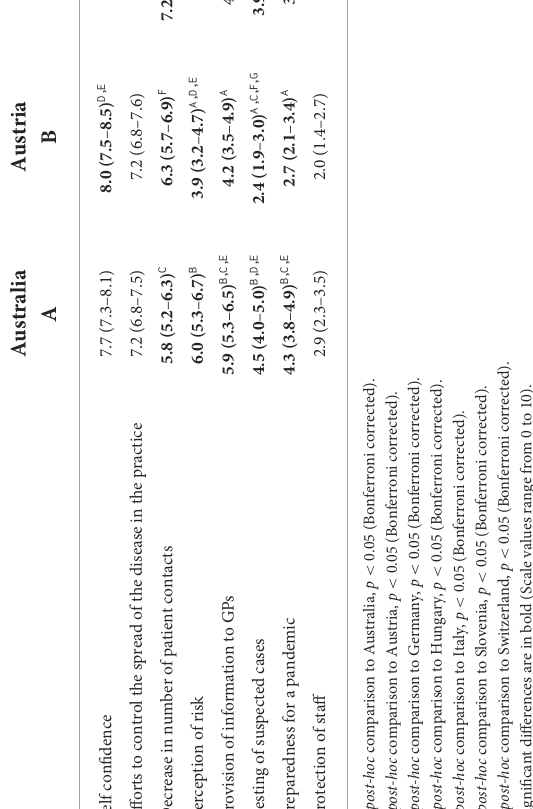
Figure 1). On an item level, the biggest difference between Austrian and Australian GPs was in their perception of their employees’ concerns about catching COVID-19 from patients (AU: 72.1 vs. AT: 37.2%). As far as the conflict between wanting to care for their patients but at the same time not wishing to endanger their families was concerned, the biggest differences were between Austrian, and Hungarian and Italian GPs